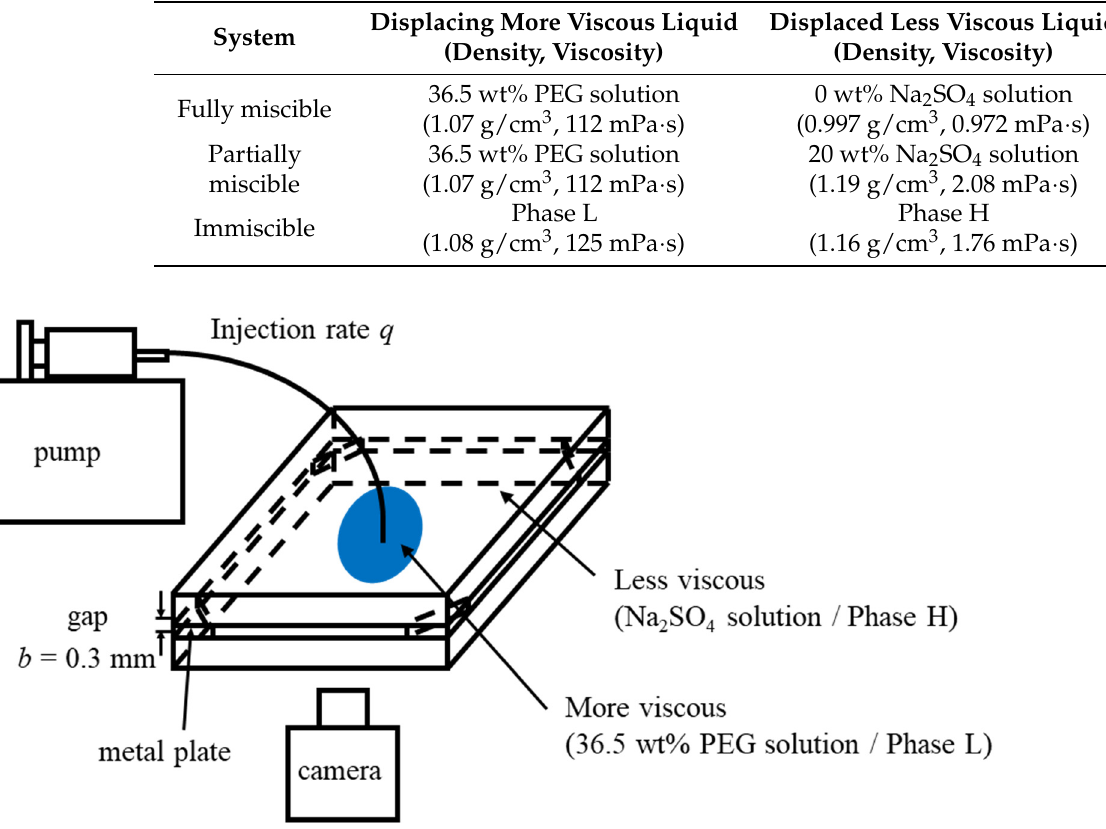
Figure 2. Schematic illustration of fluid displacement experiments [15].